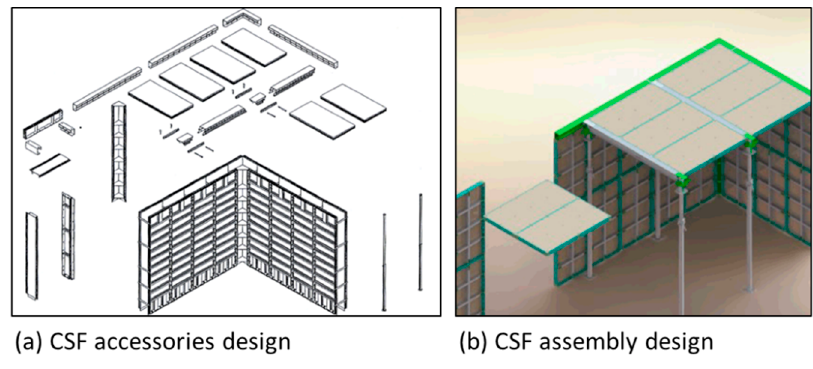
Figure 8. The CSF prototype design (( a ) accessories components design, ( b ) assembly method design).